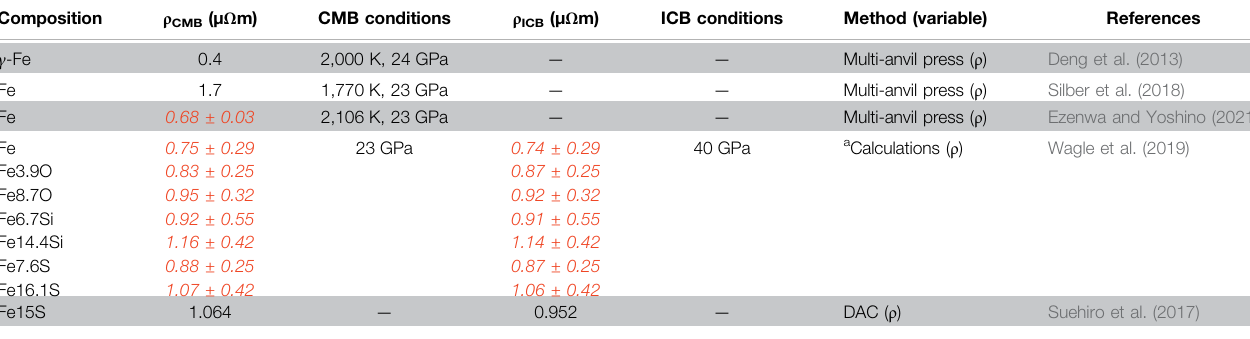
TABLE 7 | Electrical resistivity values of Fe and Fe-alloys according to different methods, at the Martian CMB (1,770 K, 23 GPa) and ICB (2,000 K, 40 GPa) conditions. Composition